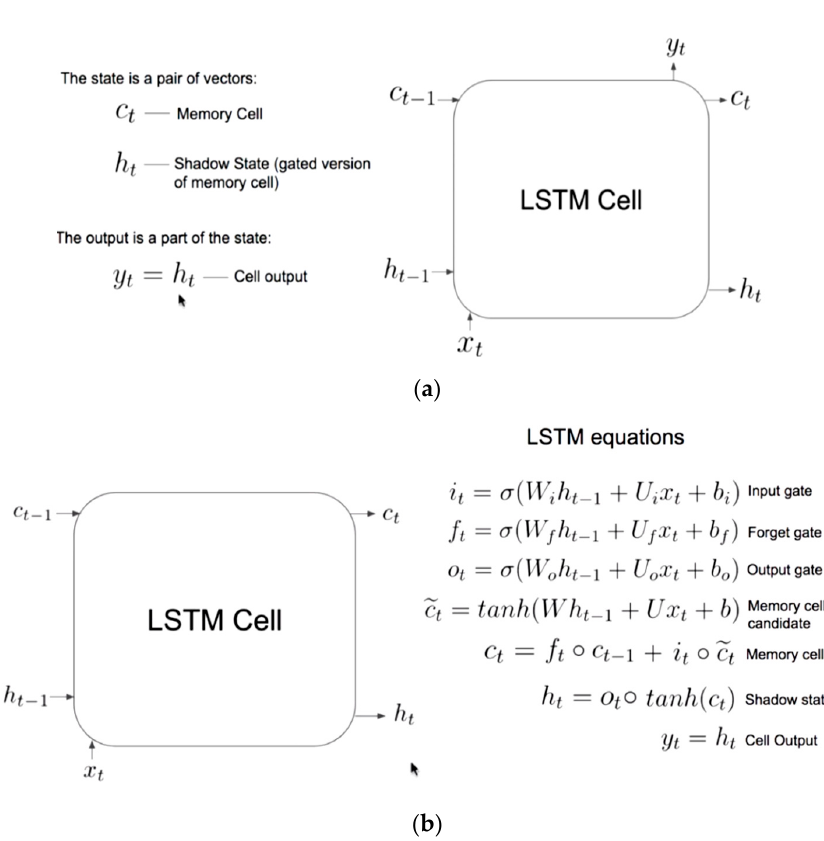
Figure 5. ( a ) A vanilla LSTM cell; ( b ) Equations of a vanilla LSTM